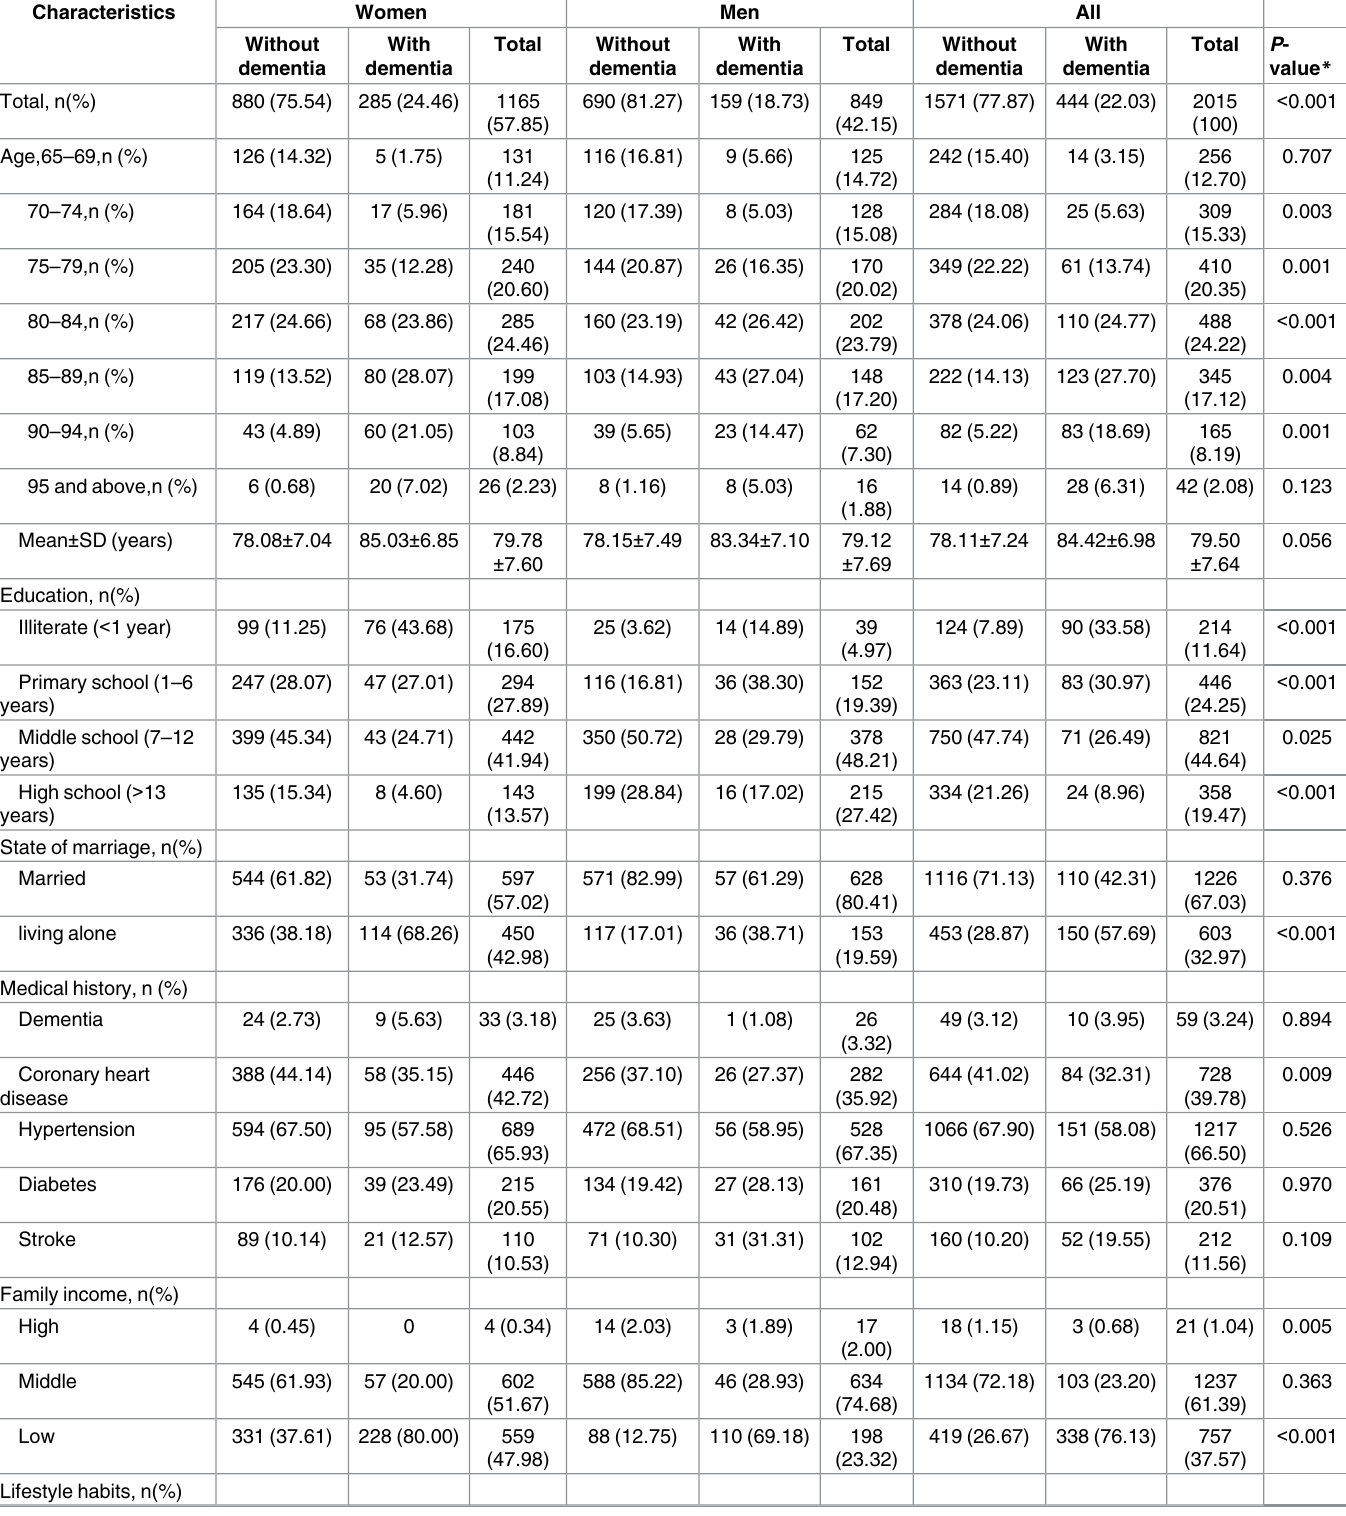
Table 1. Baseline socioeconomic characteristics with and without dementia among elderly of southern China in 2014 (n = 2015).